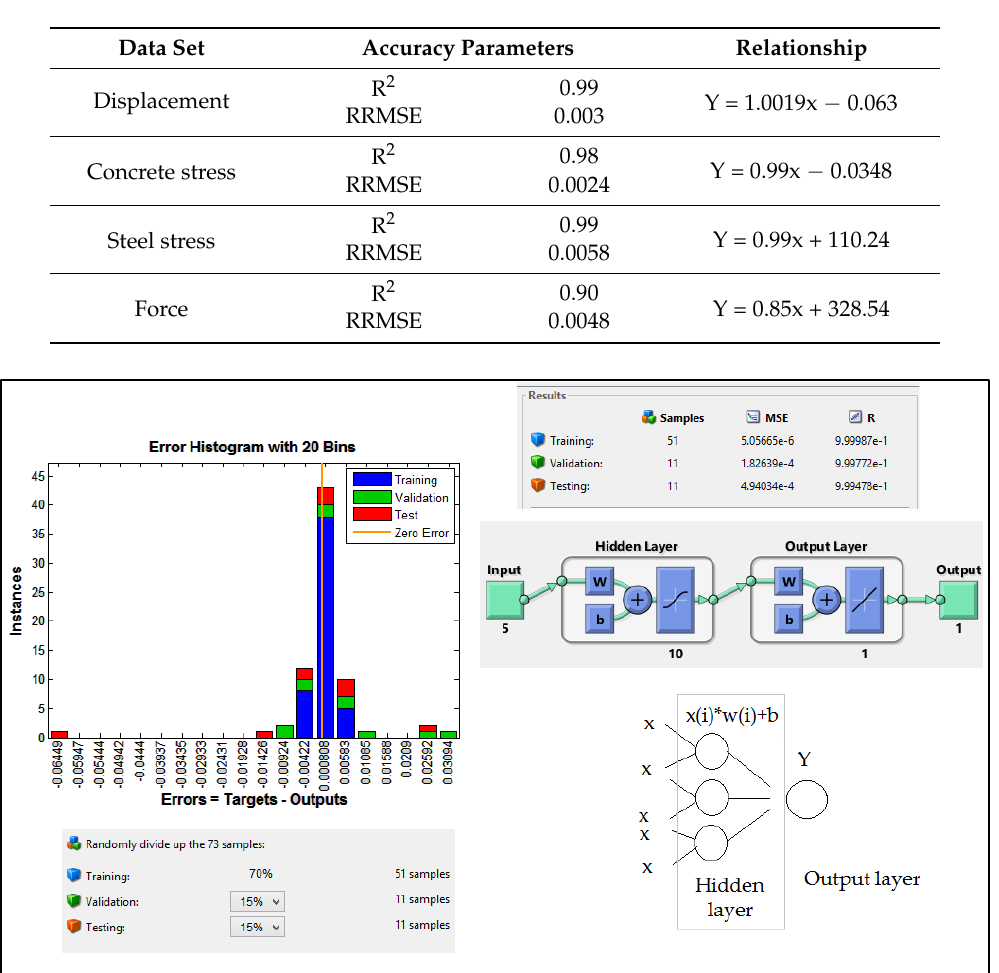
Table 2. Accuracy parameters for each output.